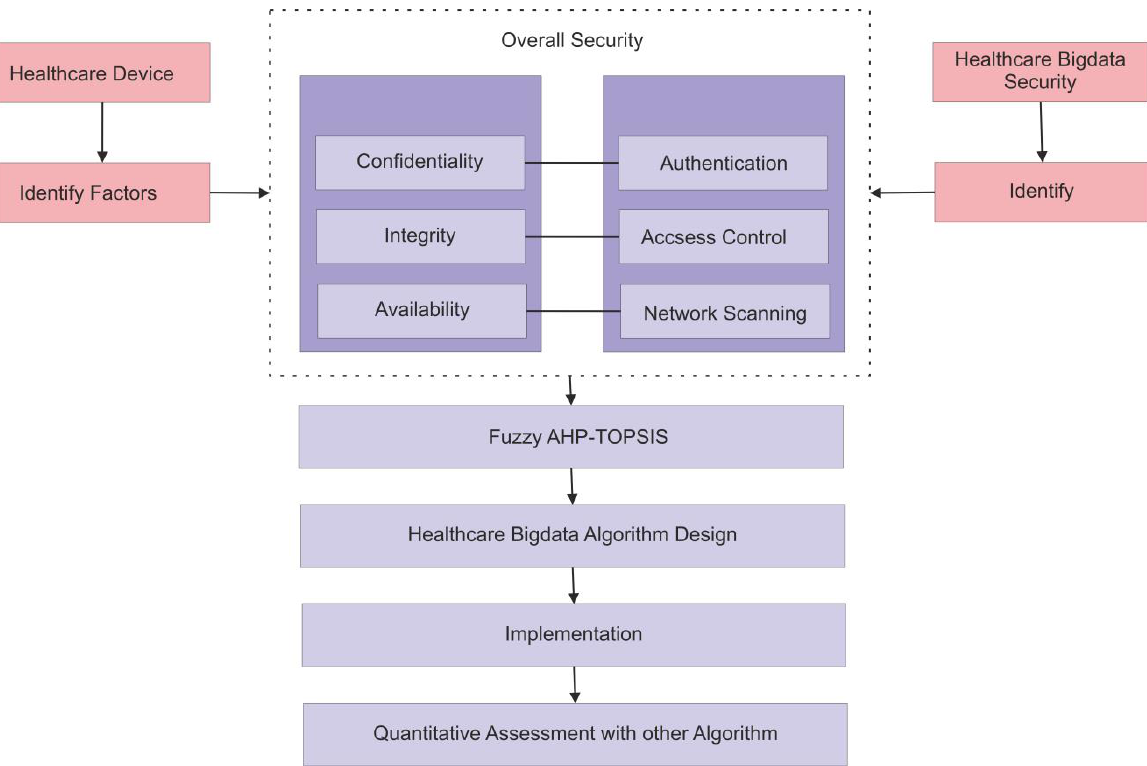
Figure 1. Framework to check the security of medical devices and healthcare big data.